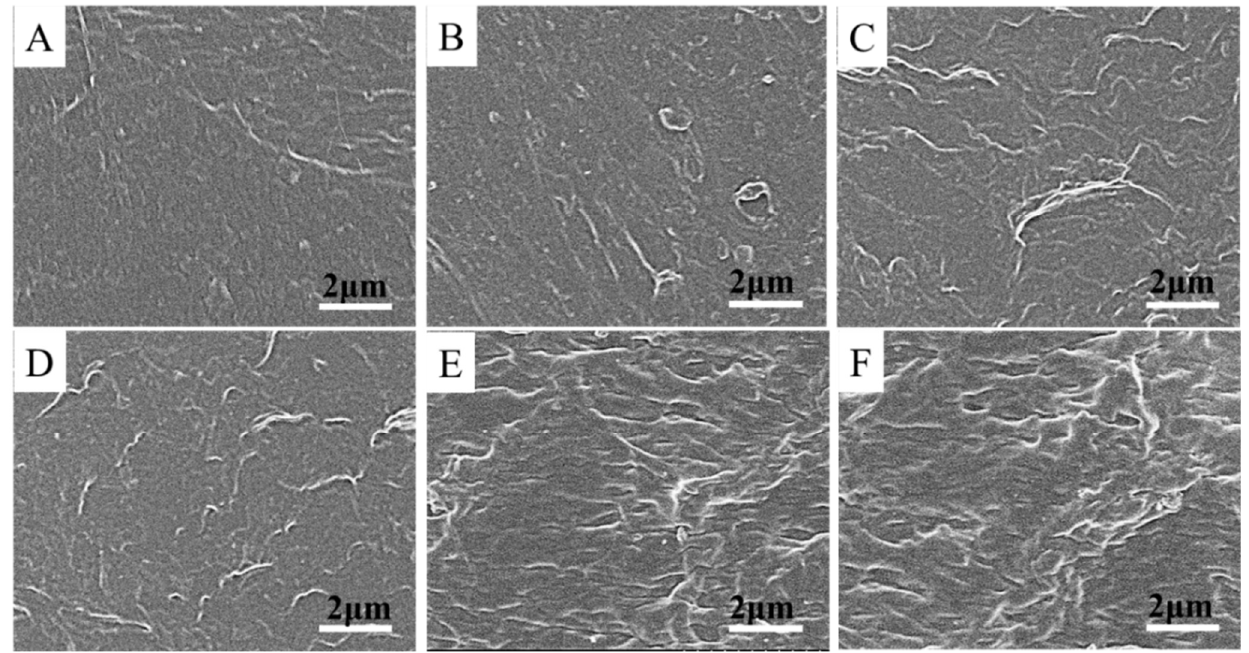
Figure 5. SEM images of PVA/TA@ANFs’ hydrogels with different TA@ANFs’ contents: ( A ) PTAA-0, ( B ) PTAA-5, ( C ) PTAA-10, ( D ) PTAA-15, ( E ) PTAA-20, and ( F ) PTAA-25.